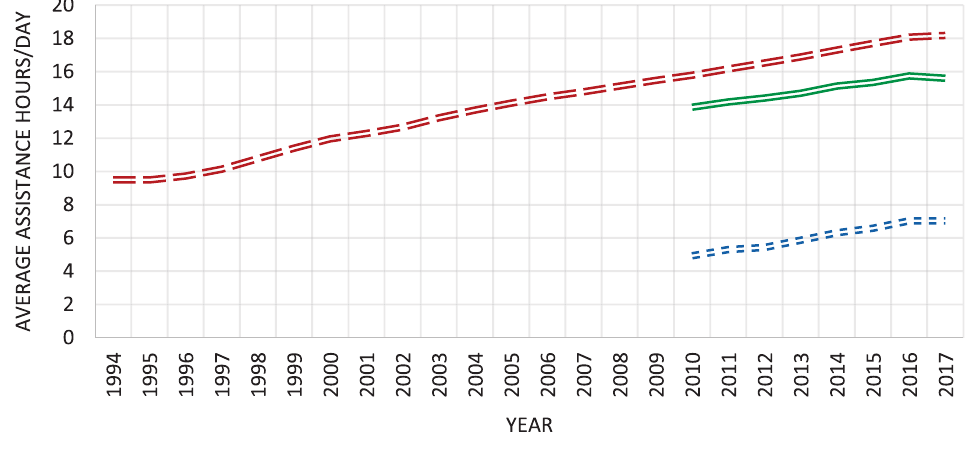
Figure 3. PA-intensity, 1994–2017. Source: own calculations based on data from SSIA, retrieved from Independent Living Institute